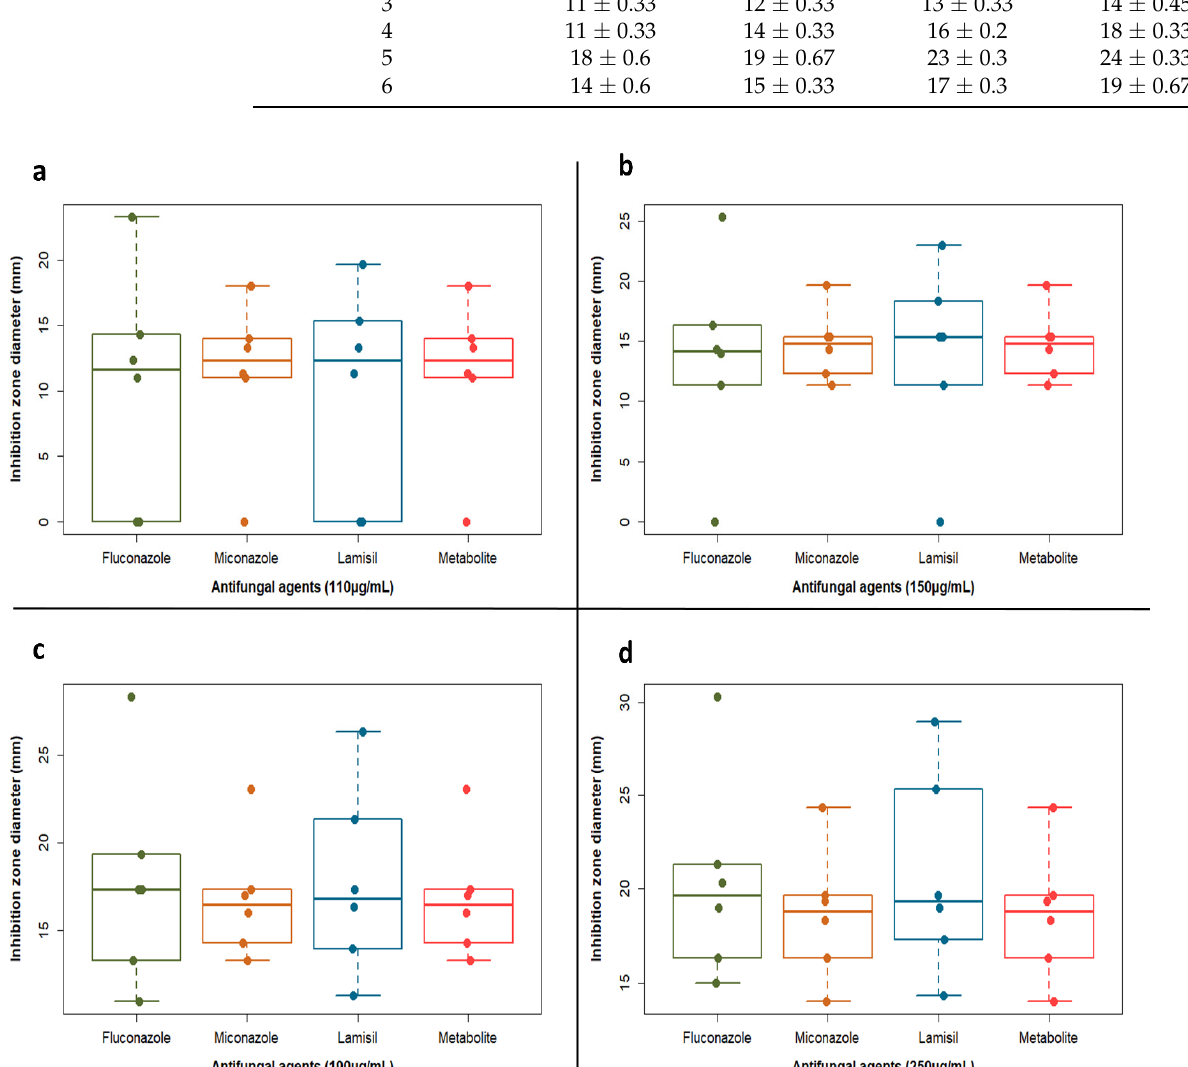
Figure 3. Boxplots showing inhibition zone diameter (mm) vs. antifungal agents (fluconazole, miconazole, Lamisil and the active metabolite) at different concentrations: ( a ) 110 µg/mL, ( b ) 150 µg/mL, ( c ) 190 µg/mL and ( d ) 250 µg/mL. Dots representing each sample were overlaid to show the actual variability and distribution of the data. Plot was created by R (“ggplot2”) package.